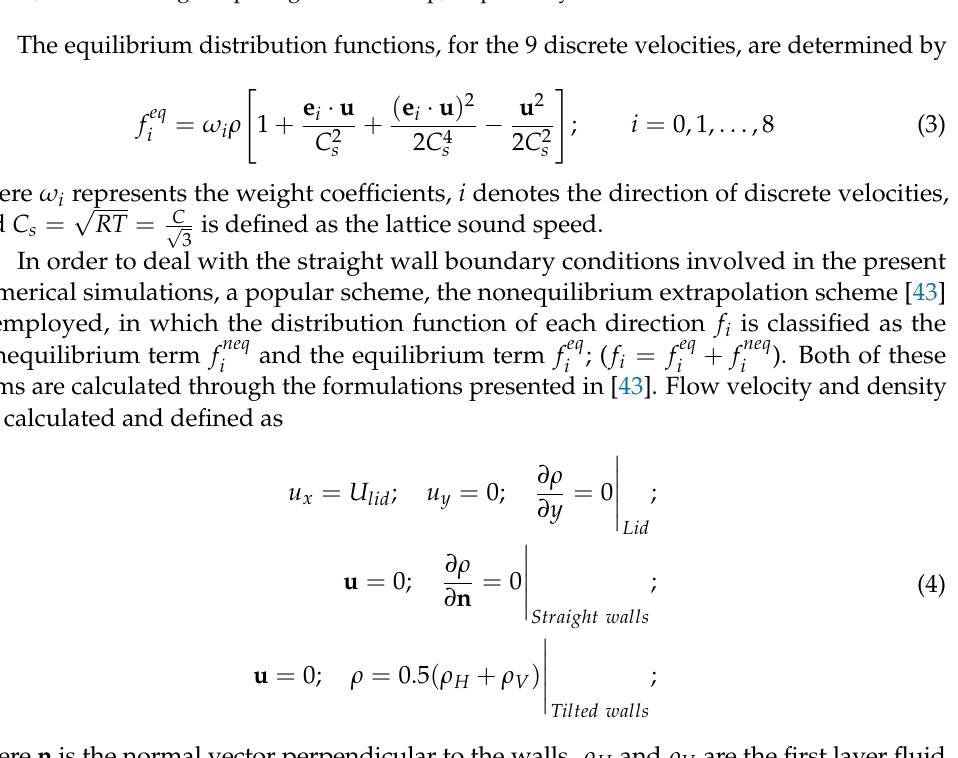
Figure 1. Discrete velocities of lattice Boltzmann D2Q9 model, where c = ∆ x ∆ and ∆ x , ∆ t are lattice grid spacing and time step,